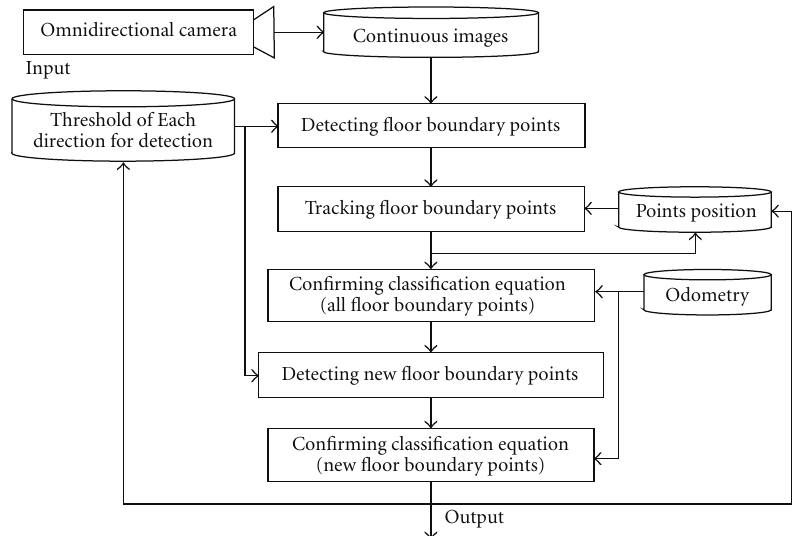
Figure 6: The whole system of classification.